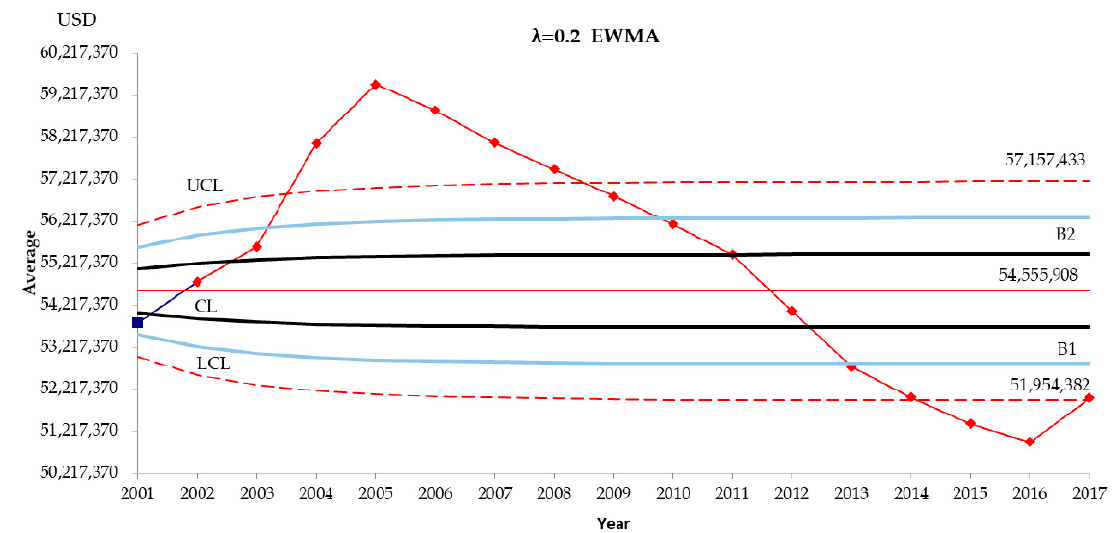
Figure 4. EWMA early warning algorithm simulation for diabetes inpatient treatment global payments when λ = 0.2.